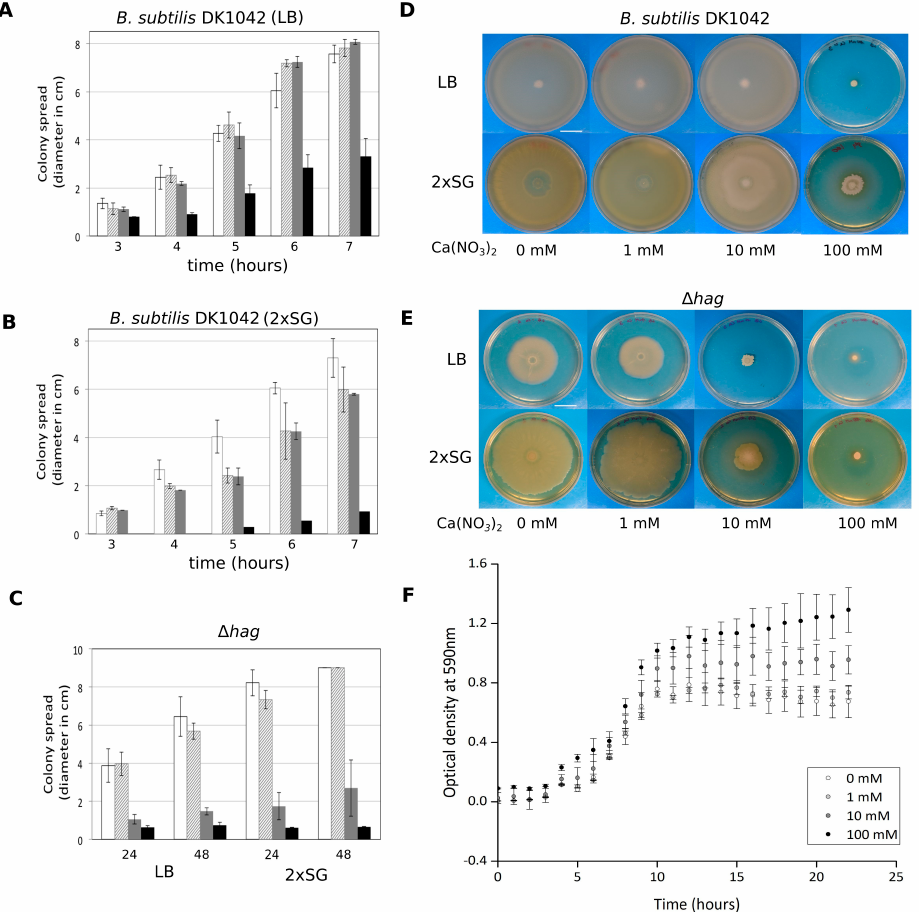
Figure 3. Impact of the presence of Ca 2+ on swarming and sliding mediated surface colonization of B. subtilis DK1042 and ∆ hag strains, respectively, on Lysogeny broth (LB) and 2 × SG medium. Swarming diameter of B. subtilis DK1042 strain after 3 to 7 h on LB ( A ) and 2 × SG ( B ) media with 0.7% agar without (white bars) or with 1 (stripped bars), 10 (grey bars), 100 mM (black bars) Ca 2+ supplemented. Sliding diameter of B. subtilis ∆ hag strain ( C ) after 24 and 48 h on LB (left) and 2×SG (right) media supplemented with various amount of Ca(NO 3 ) 2 (labelling similar to S4A). Swarming ( D ) and sliding ( E ) disk of wild type (WT) and ∆ hag strains, respectively, 24 h after inoculation on LB (above) and 2 × SG (below) media with 0.7% agar in the absence or presence of various amounts of Ca 2+ supplementation. Scale bars indicate 2 cm. Growth properties of B. subtilis DK1042 ( F ) in 2×SG medium supplemented with different amount Ca(NO 3 ) 2 from 1 mM to 100 mM.